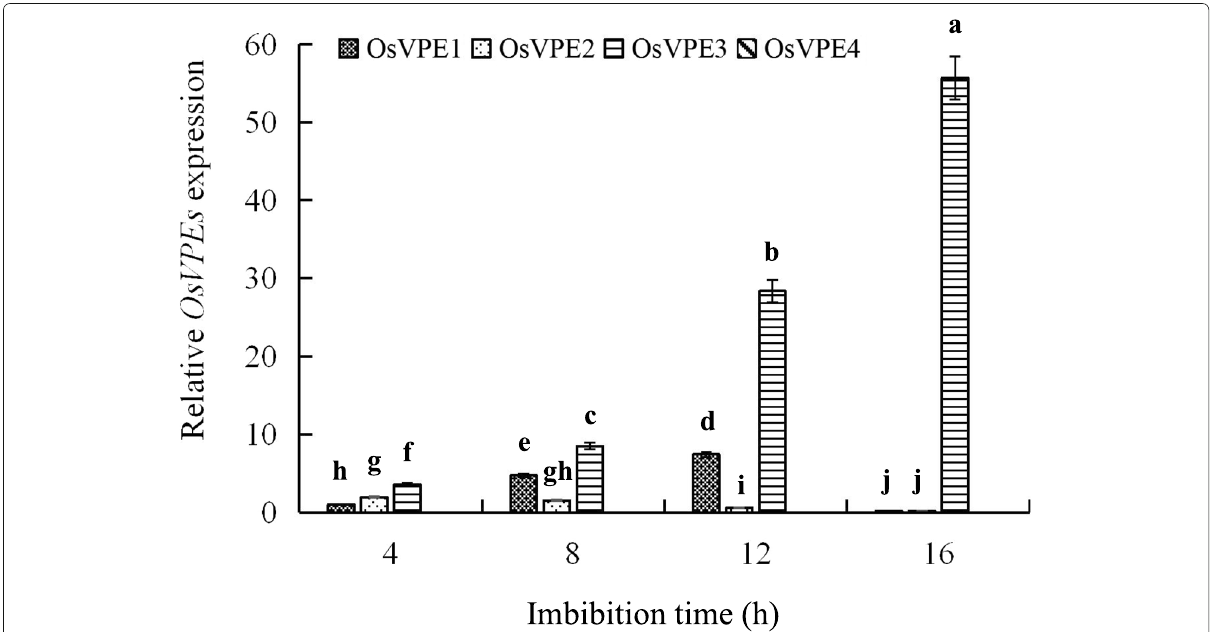
Fig. 1 The levels of OsVPE3 gene expression changed over time. Aleurone layers were stripped from the intact seeds imbibed for 4, 8, 12, and 16 h, and then the mRNA transcripts of OsVPE1 , OsVPE2 , OsVPE3 , and OsVPE4 were measured. The expression of OsVPE1 in 4 h was selected as 1. Error bars represent the means ± s.d., n = 3 biological independent experiments with at least three replicates for each. Bars with different alphabets show significant different at P < 0.05 by Duncan’s multiple range